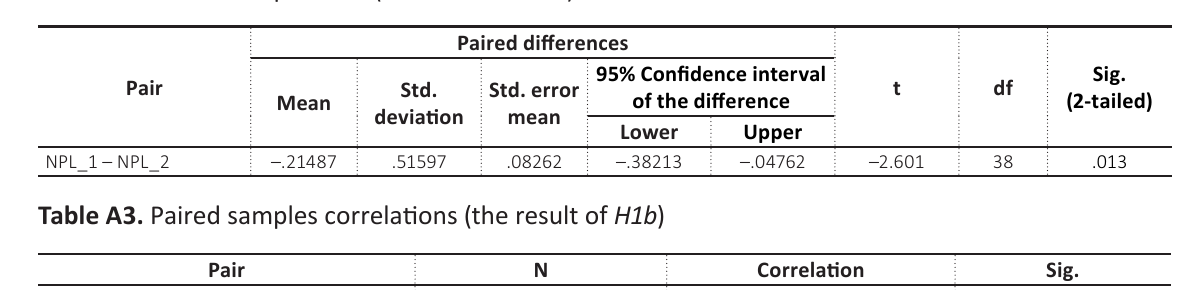
Table A2. Paired samples test (the result of H1a )